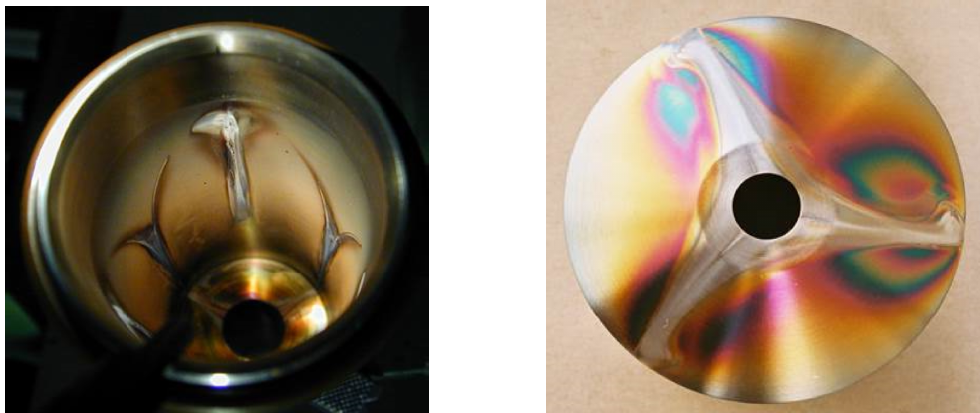
Figure 2. Left: six loss lines in the center of the plasma chamber and the hole for microwave injection. Right: the extraction electrode (plasma side) with three loss